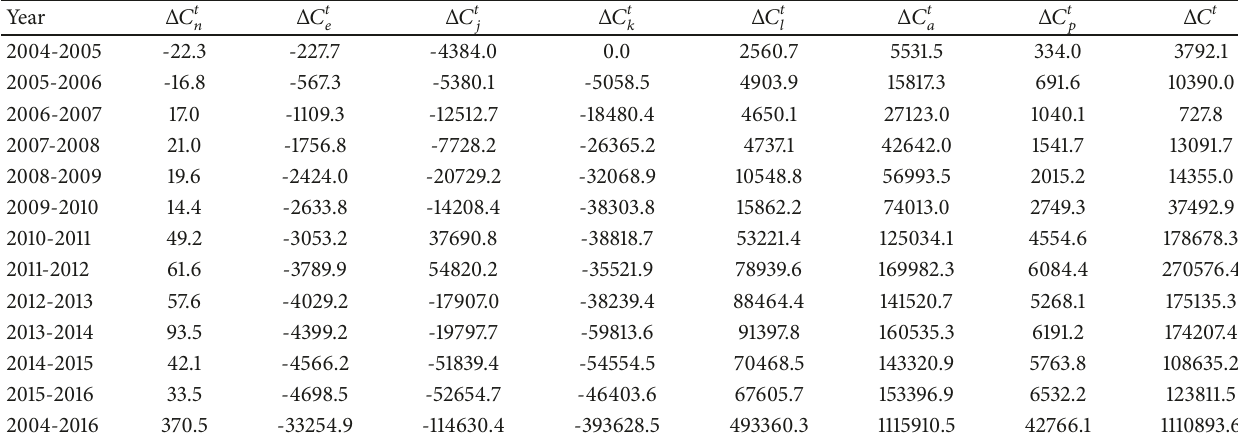
Table 3: The decomposition of different factors on CO 2 emissions change in China’s construction industry during 2004-2016.